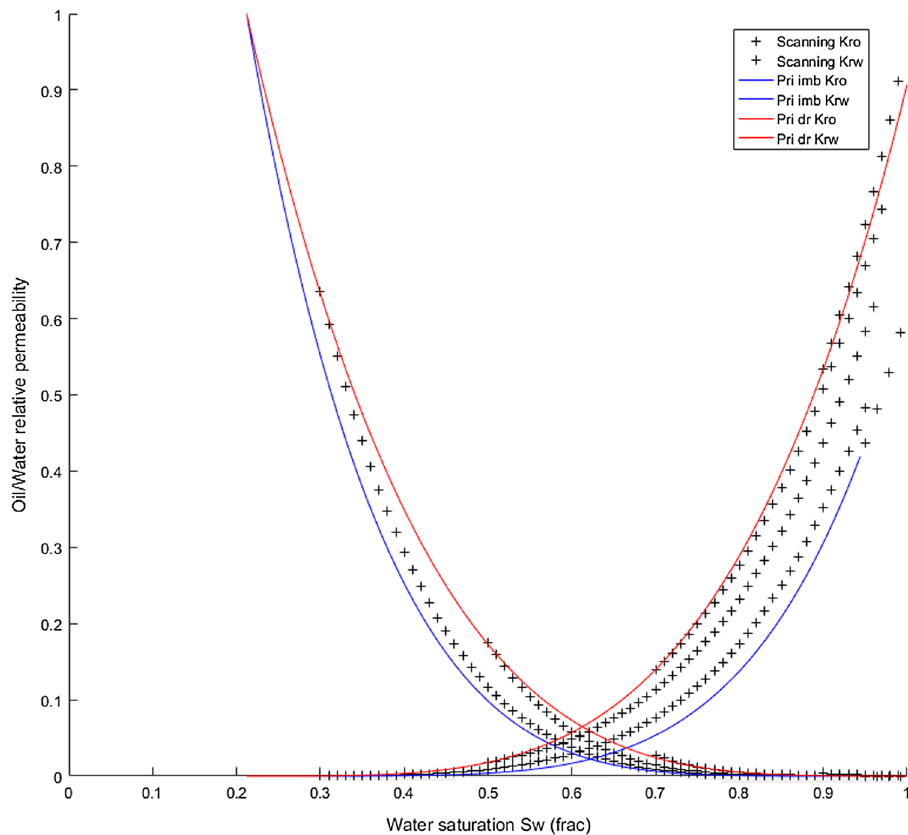
Fig. 14 Bounding drainage/ imbibition curve and scan- ning curve for rock type 2 (Masalmeh model, linear-type S S oi / or